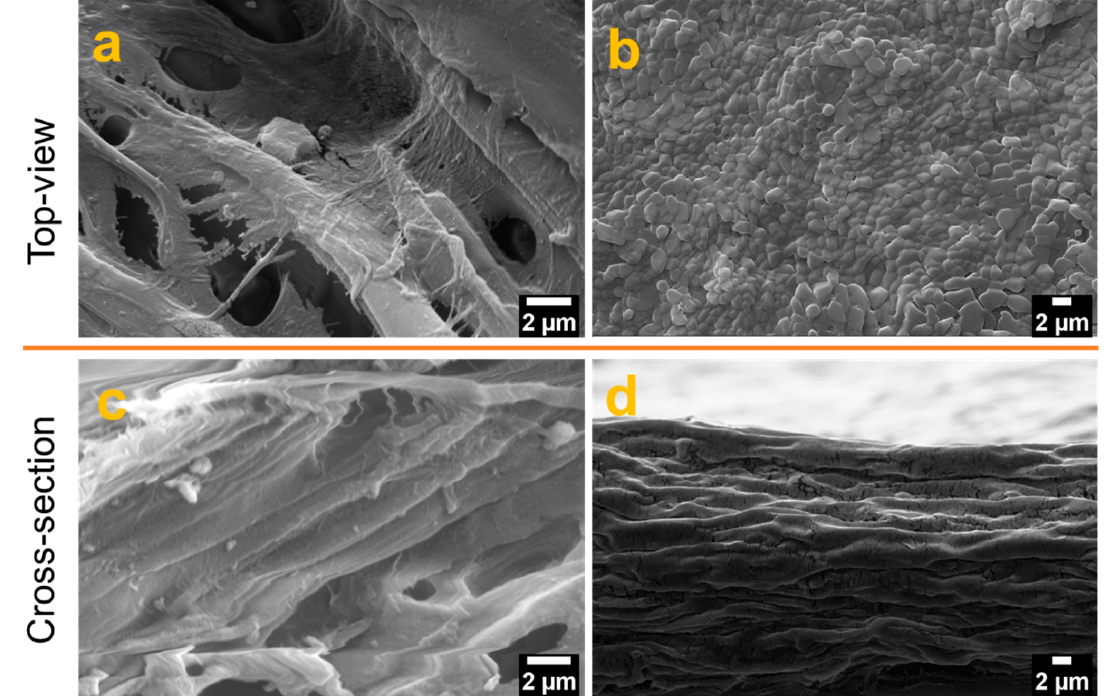
Figure 4. Film morphology at different magnification by FE-SEM: top view (top) images ( a ) (12,000 × ) and ( b ) (5000 × ), and cross-section view (bottom) ( c ) (16,000 × ) and ( d ) (5000 × ) of CNF, and TOCNF/G, respectively.